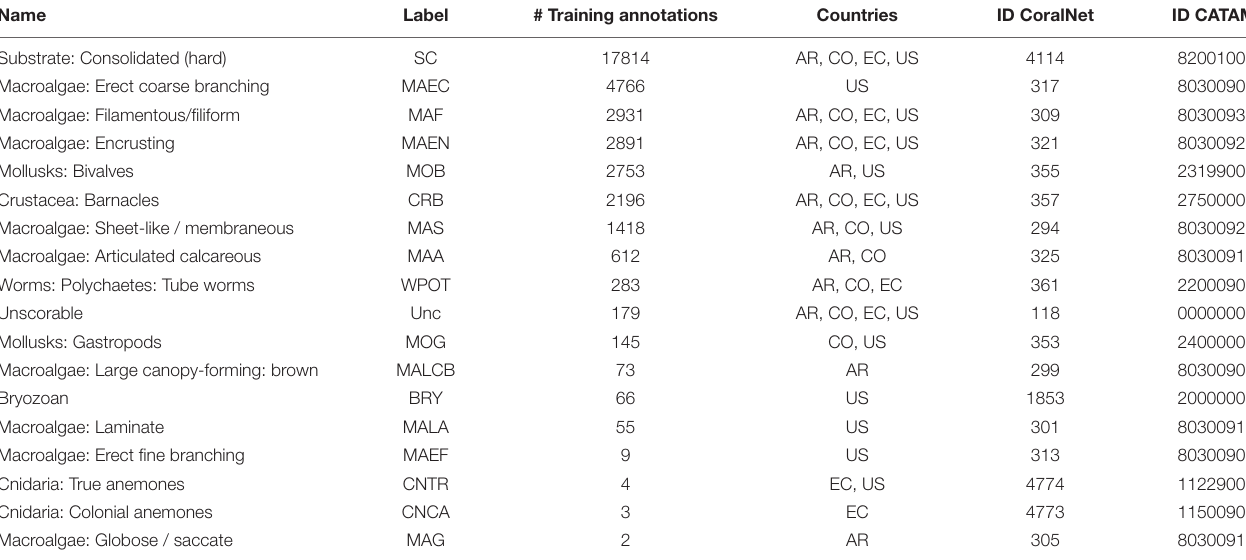
TABLE 2 | Collaborative and Automated Tools for Analysis of Marine Imagery (CATAMI) classification scheme used in this